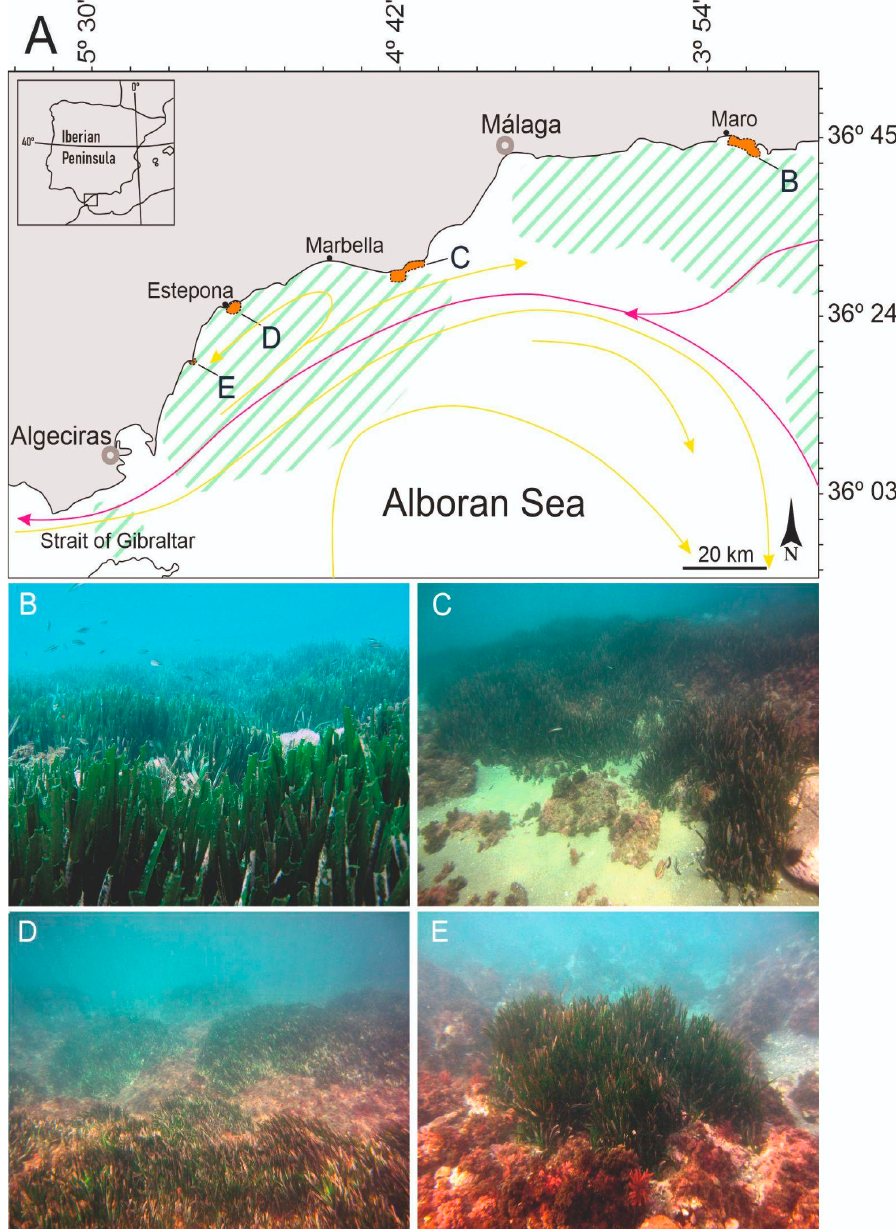
Figure 1. Map of the study area in the northwestern Alboran Sea and images of the general configuration of Posidonia oceanica patches in the studied meadows. ( A ) General map. Orange areas indicate the location of the different sites with P. oceanica meadows sampled: ( B ) Maro MPA, ( C ) Calahonda SAC, ( D ) Estepona SAC and ( E ) Chullera. Green lines indicate areas influenced by nutrient-rich upwellings; yellow arrows indicate the direction of the Surface Atlantic Waters and pink arrows indicate the direction of the Mediterranean Intermediate and Deep. Redrawn from http://www.juntadeandalucia.es/medioambiente/rediam (accessed on: 14 April 2022). The main objectives of this study are (1) to characterize P. oceanica meadows at its westernmost gradient of distribution in the Mediterranean Sea; (2) to analyze the seasonal and interannual variation of different phenological parameters in the Mediterranean– Atlantic transition region in comparison to other Mediterranean areas; and (3) to evaluate flowering events in different P. oceanica meadows of the northwestern Alboran